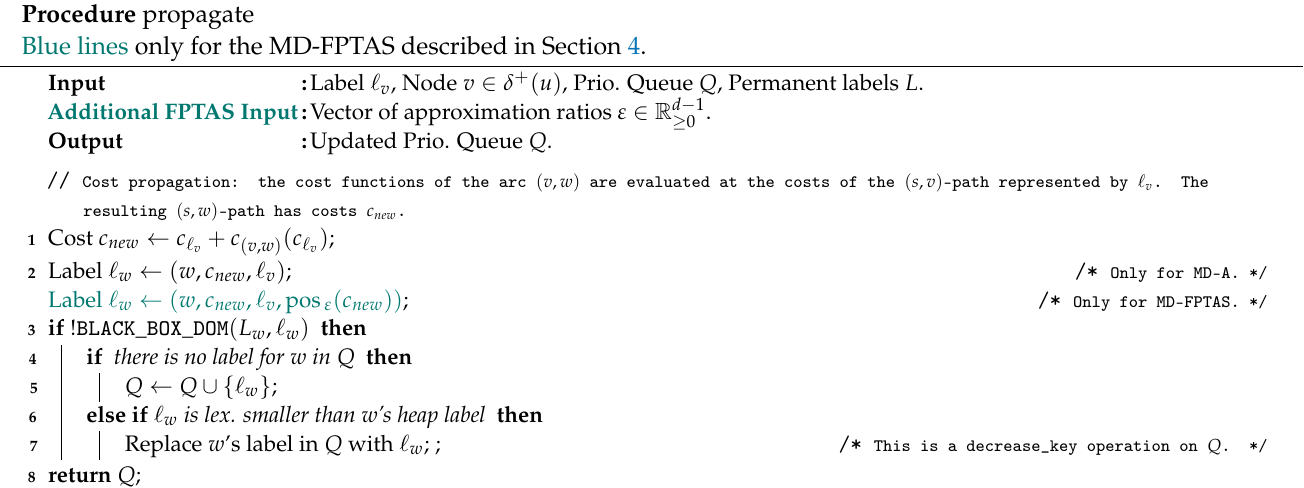
Procedure propagate Blue lines only for the MD-FPTAS described in Section